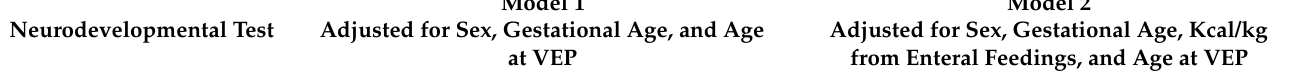
Neurodevelopmental